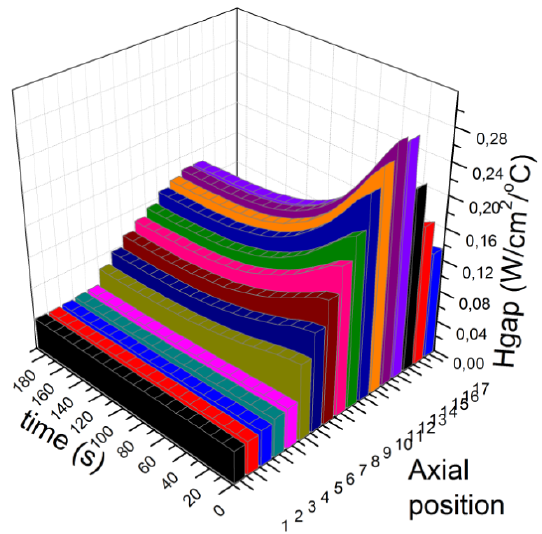
Fig. 18. H gap pro fi le evolutions during ULOF/PP accident for one sub-assembly from the outer core.